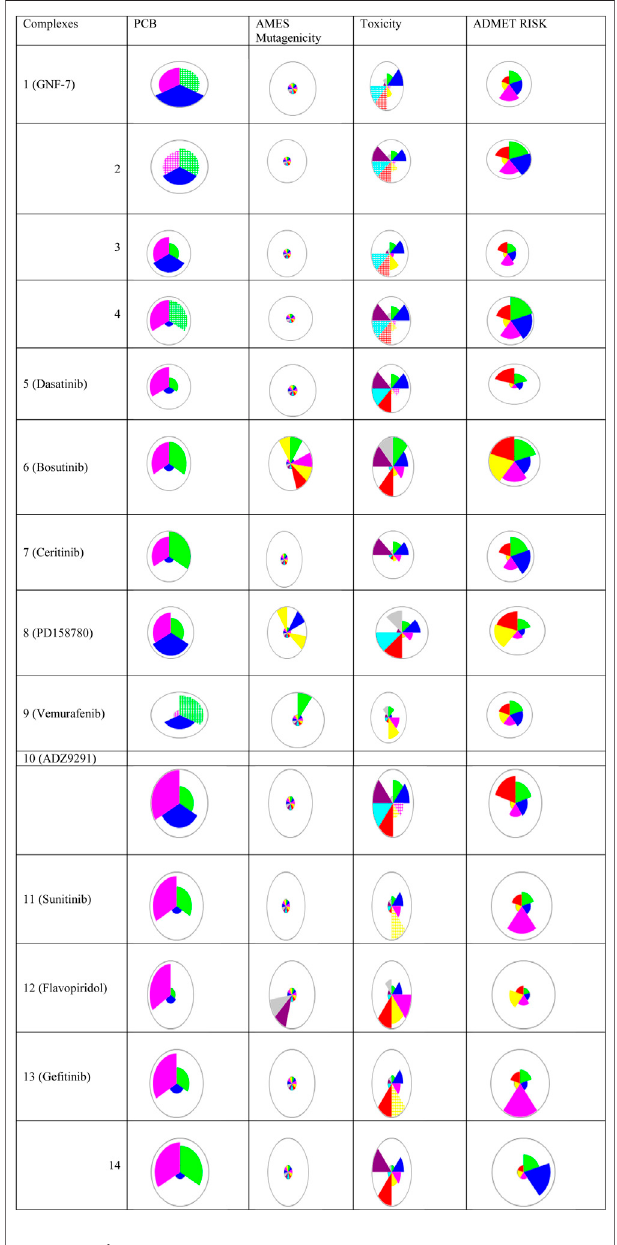
FIGURE 3 | Chemical structures, names, and star plots of physicochemicalandbiopharmaceutical(PCB), Salmonellatyphimurium reverse mutation assay (AMES) mutagenicity, toxicity, and risk prediction for 14 multikinase inhibitors as predicted by Simulations Plus ADMET Predictor 10.2. Wedges represent out-of-scope predictions (hatched due to the model ’ s applicability domain). PCB [solubility + log P (pink), molecular weight (MW) (green), and number of free rotations (blue)]; AMES (colors representing mutagenicity); toxicity (Ser_ALT (blue), Ser_AST (red), herG IC 50 (green), mutagenic risk (gray), and Ser_LDH (violet)); ADMET risk (toxicity (red); ADMET (green); absorption (blue); CYP risk (pink), and mutagenic risk (yellow)).